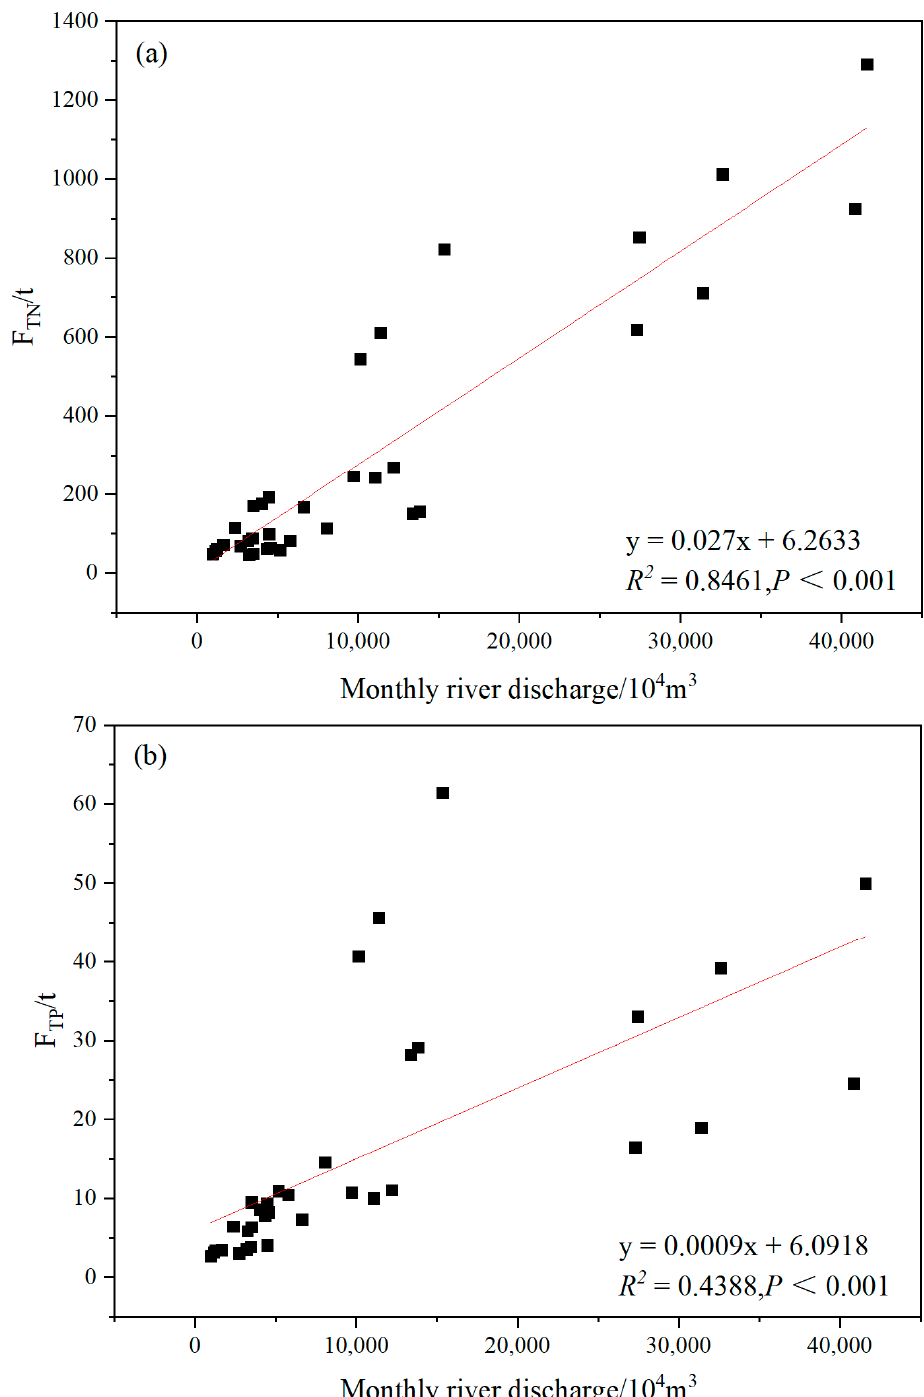
Figure 7. Seasonal variations of TN and TP fluxes in the estuarine of the Maowei Sea. ( a ) The relationship between TN flux and monthly river flow. ( b ) The relationship between TP flux and monthly river flow.